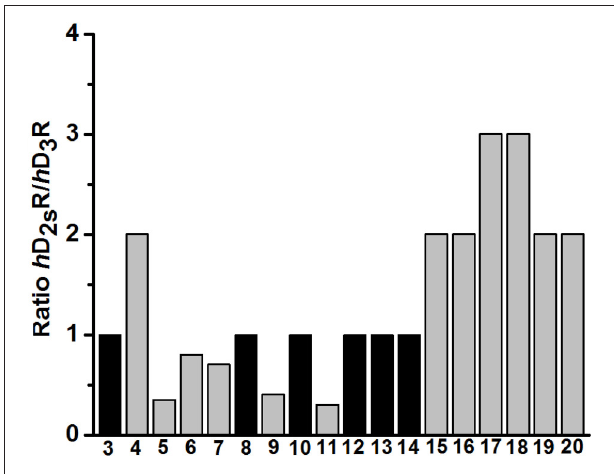
showed LE > 0.3 for h D 2S Rs and h D 3 Rs, whereas the correlation of observed LELP values ( h D 2S Rs and h D 3 Rs) were not existing, and were found > 9 ( Table 3 ). Importantly, the LipE values which are considered to be independent on molecular size of the respective ligand were found for all ligands < 5 by considering the affinity of each respective ligand for h D 2S Rs and h D 3 Rs. The LipE results observed for the current series further corroborate their drug-likeness ( Table 3